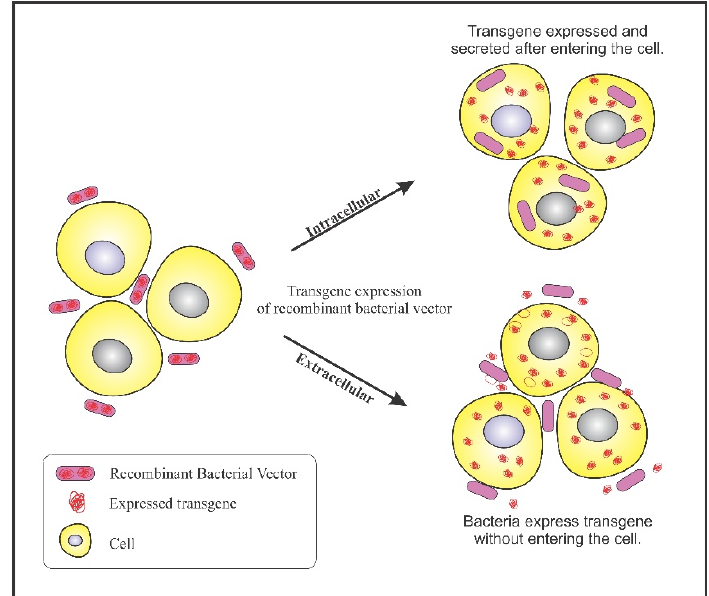
Figure 2. Bactofection into tumor cells: Intercellular: bacteria bearing the transgene penetrates into the tumor cells, undergo lysis and release the transgene inside the tumor cell; Extracellular: bacteria bearing the transgene do not enter the cell but, expresses the transgene in the vicinity of the tumor cells.